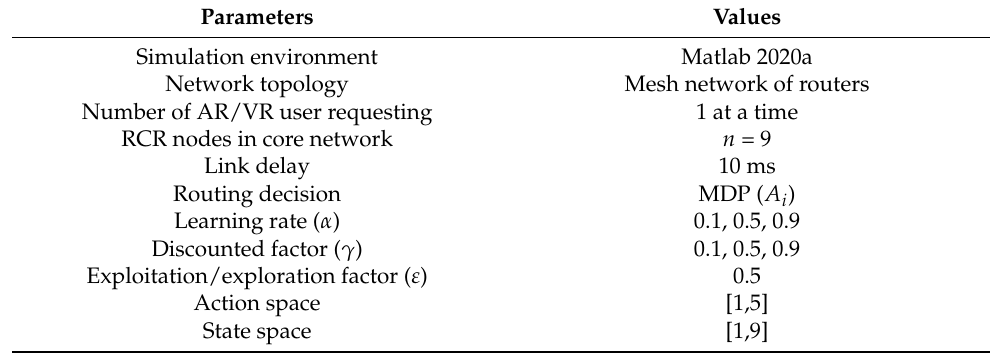
Table 2. Simulation